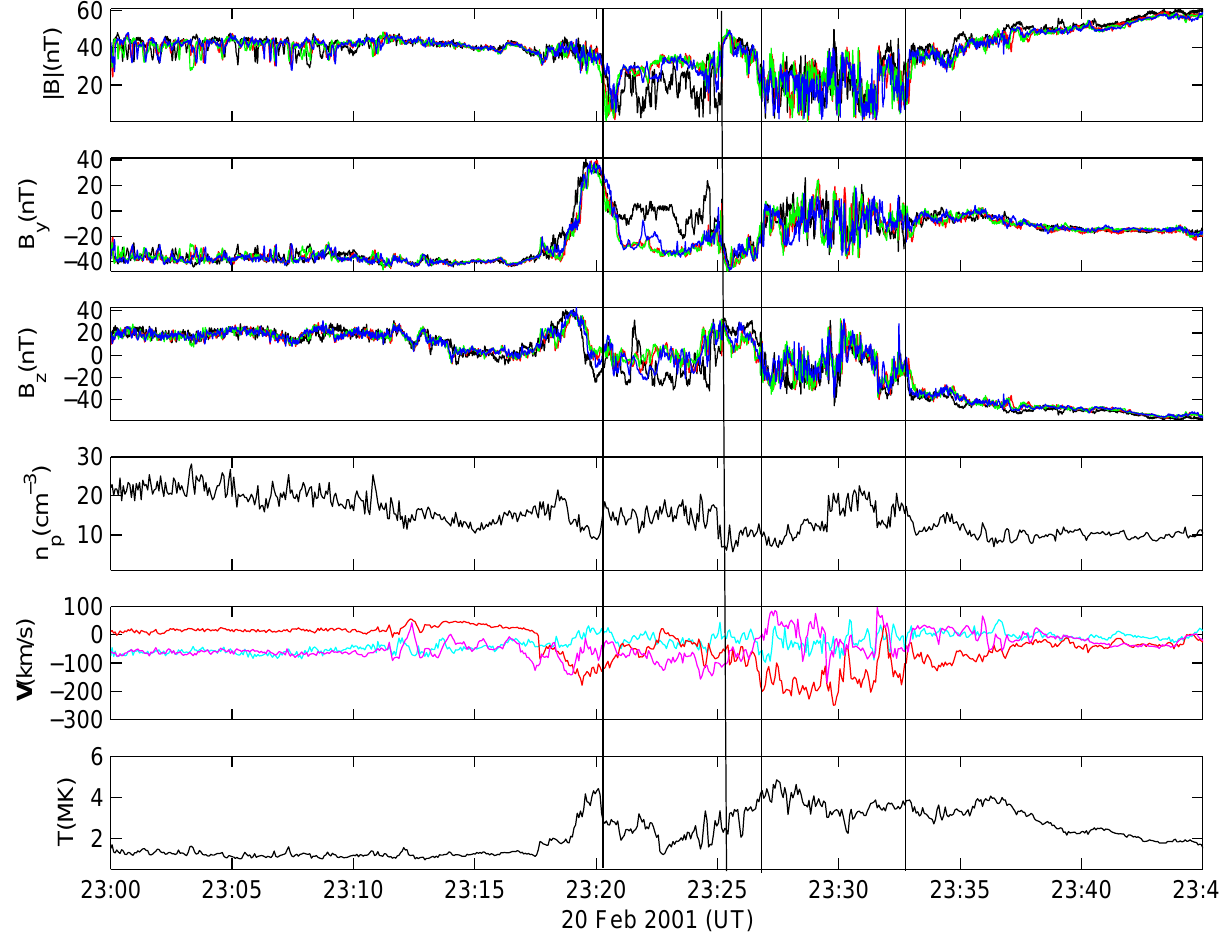
Fig. 11. An overview of the magnetic field and plasma parameters between 23:00 and 23:45UT on 20 February 2001. The six panels show | B | , B y B z , n, V and T. The three components of the plasma velocity seen by spacecraft 1 are denoted by cyan, red and magenta lines in panel 5. The four vertical lines refer to features discussed in the